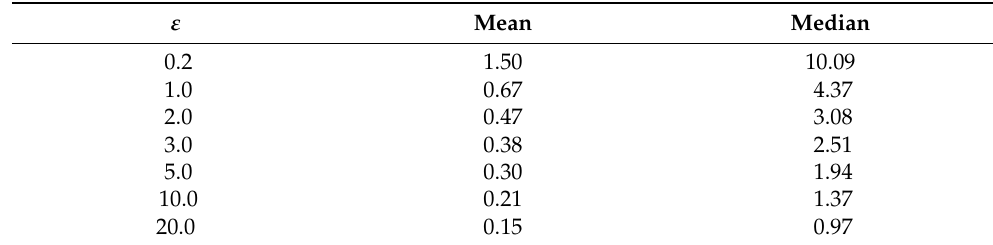
Figure 1. R 2 of DP-BCD in artificial test data. ( a ) R 2 after DP-BCD as a function of ε ; ( b ) R 2 after DP-BCD as a function of γ . Table 1. Mean and median proportional absolute error of β estimates compared to centralized setting, over ε after five iterations for γ =